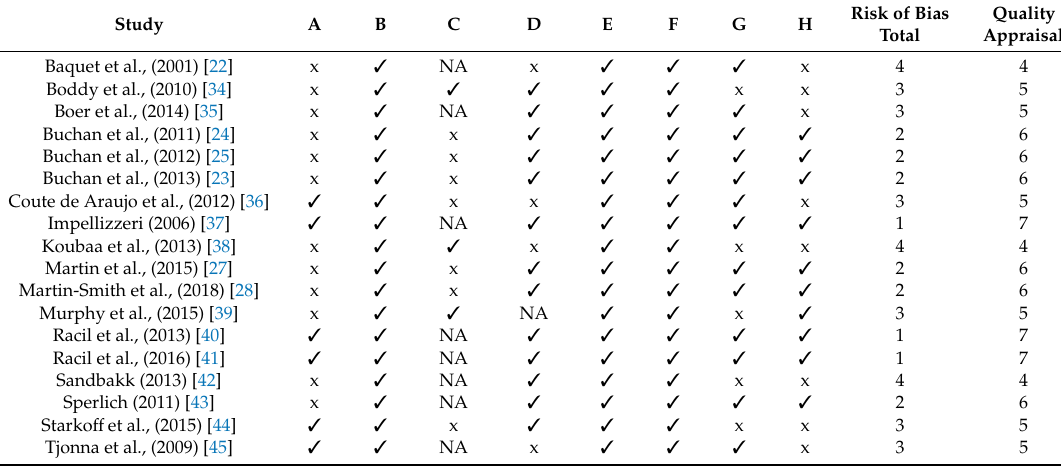
Table 1. Risk of bias and Quality Appraisal